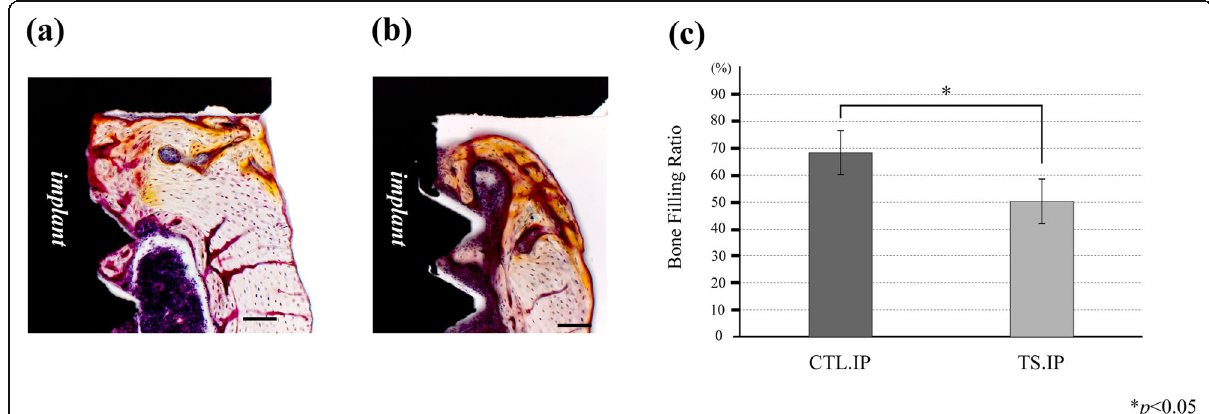
Fig. 7 Quantitative evaluation by the bone filling ratio surrounding the implant. a CTL.IP. Peri-implant area. 100× magnification. b TS.IP. Peri- implant area. 100× magnification. c Comparison of bone filling ratio. The horizontal axis shows the groups, and the vertical axis shows the bone filling ratio (%). Bar: 100 μ m